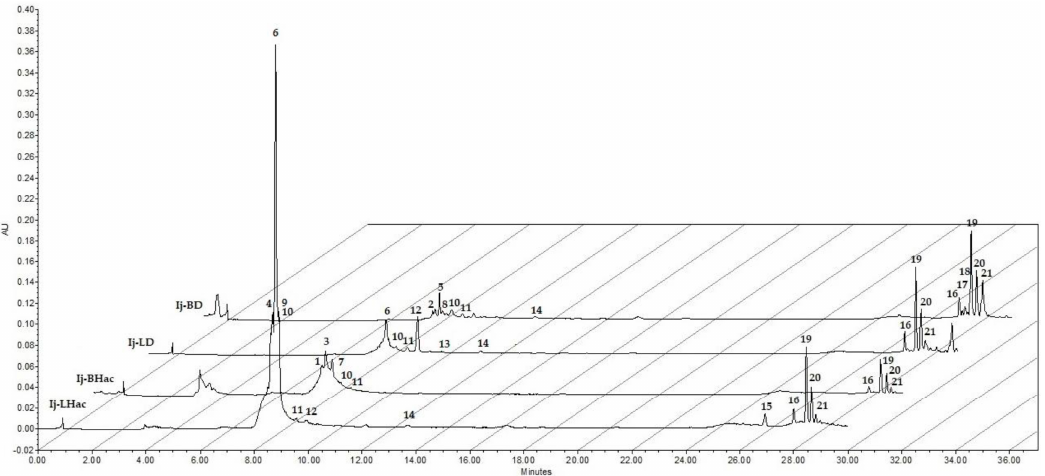
Figure 1. HPLC chromatograms of bark ( Ij-BD , Ij-BHac ) and leaf ( Ij-LD , Ij-LHac ) extracts. The peaks are numbered in ascending order according to their retention times ( λ = 270 nm). Table 2. Preliminary phytochemical profile by HPLC-UV-Vis analysis of polar extracts from bark and leaves of I. jinicuil.